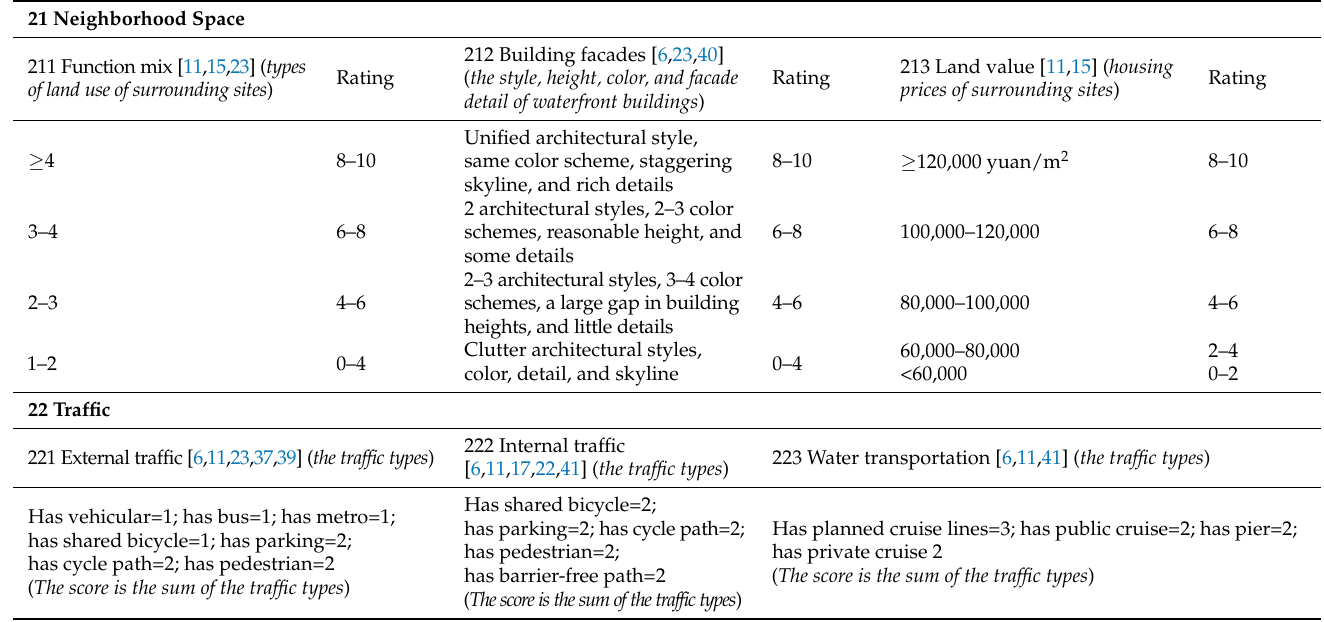
Table 10. Rating for elements of spatial subsystem.